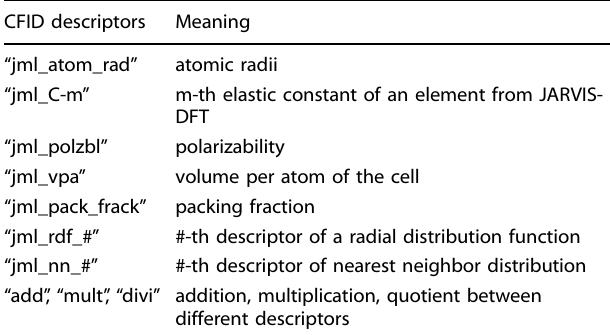
Fig. 3 The fi ve most important features according to SHAP ranking for each of the properties of interest. Results are reported for a Henry coef fi cient for CO 2 , b working capacity for CO 2 , c Henry coef fi cient for H 2 O, d surface area. In each panel, for each feature (i.e., each line), 1639, 1641, 1641, and 1006 dots are shown respectively, representing the entire testing sets used for computing the related SHAP values (impacts on the model output, horizontal axes); the color represents the corresponding feature value, the features are sorted according to the mean over the absolute SHAP values. Table 2. Physicochemical meaning of the most relevant CFID descriptors 47